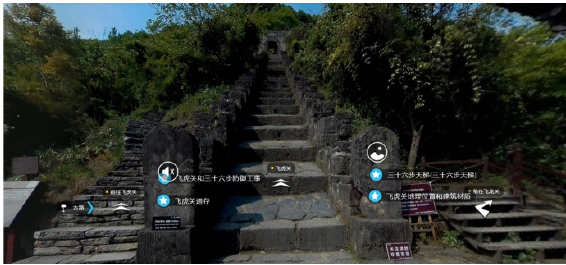
Figure 22 . Panoramic presentation system for 36-step ladder.